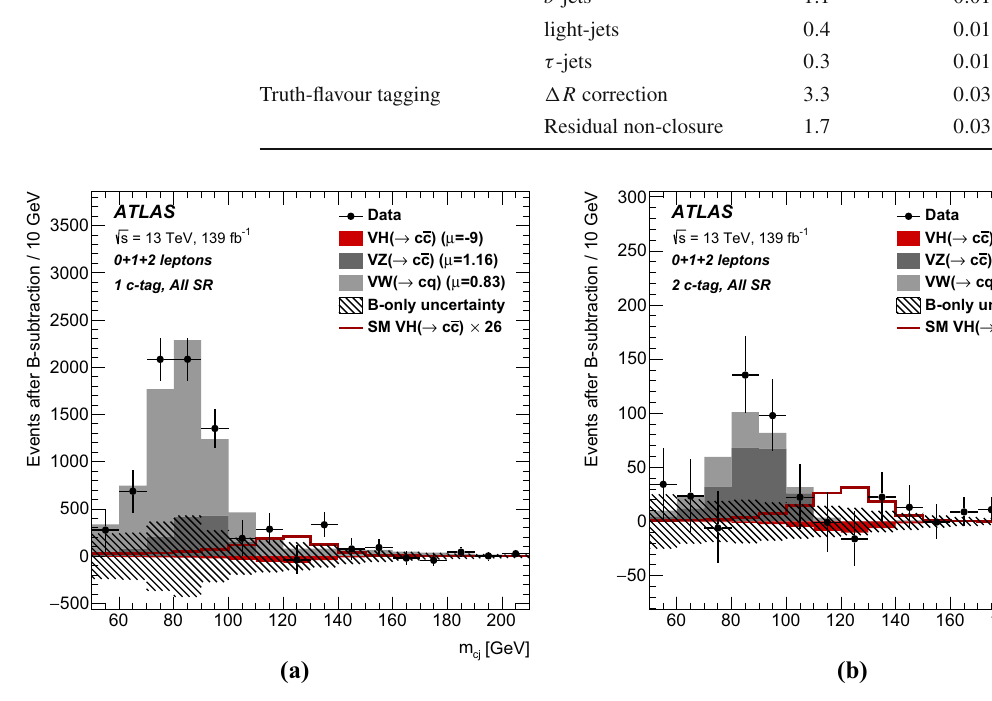
Fig. 3 The post-fit m cc distribution summed over all signal regions after subtracting backgrounds, leaving only the V H ( → c ¯ c ) , V W ( → cq ) and V Z ( → c ¯ c ) processes, for events with a one c -tag and b two c -tags. The red filled histogram corresponds to the V H , H → c ¯ c